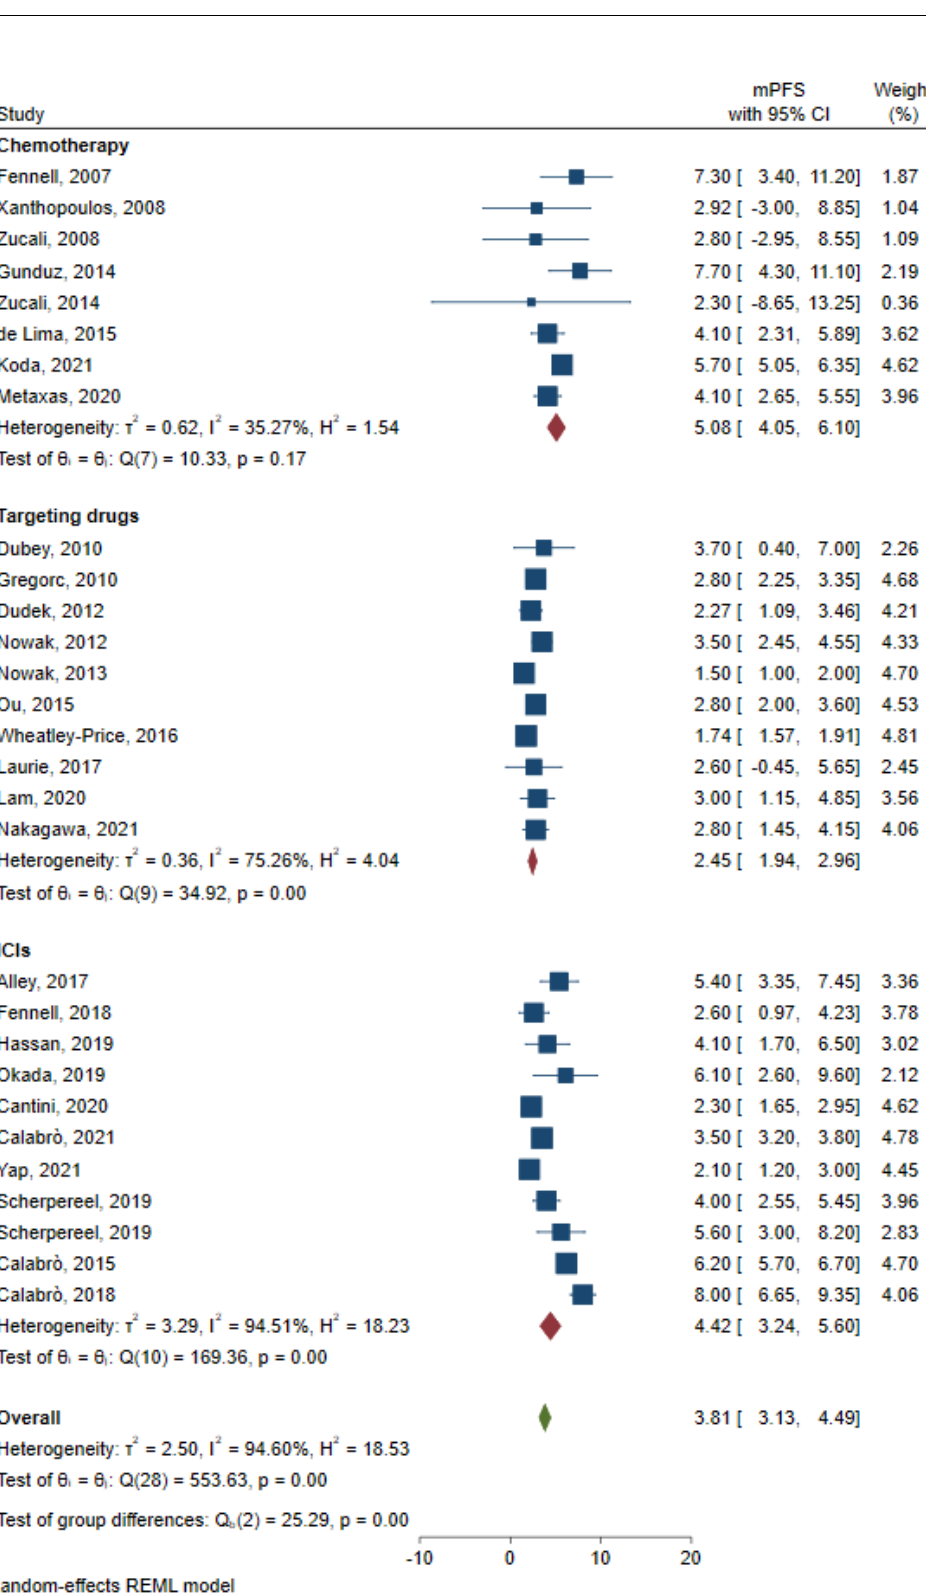
Figure 3. Pooled analysis of mPFS for chemotherapy, ICIs and, targeting drugs [7,9 –